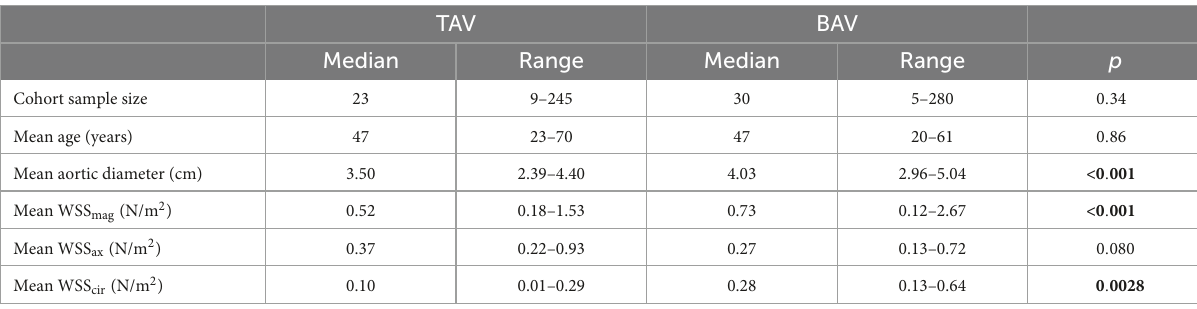
TABLE 1 Summary of key numerical data of the included